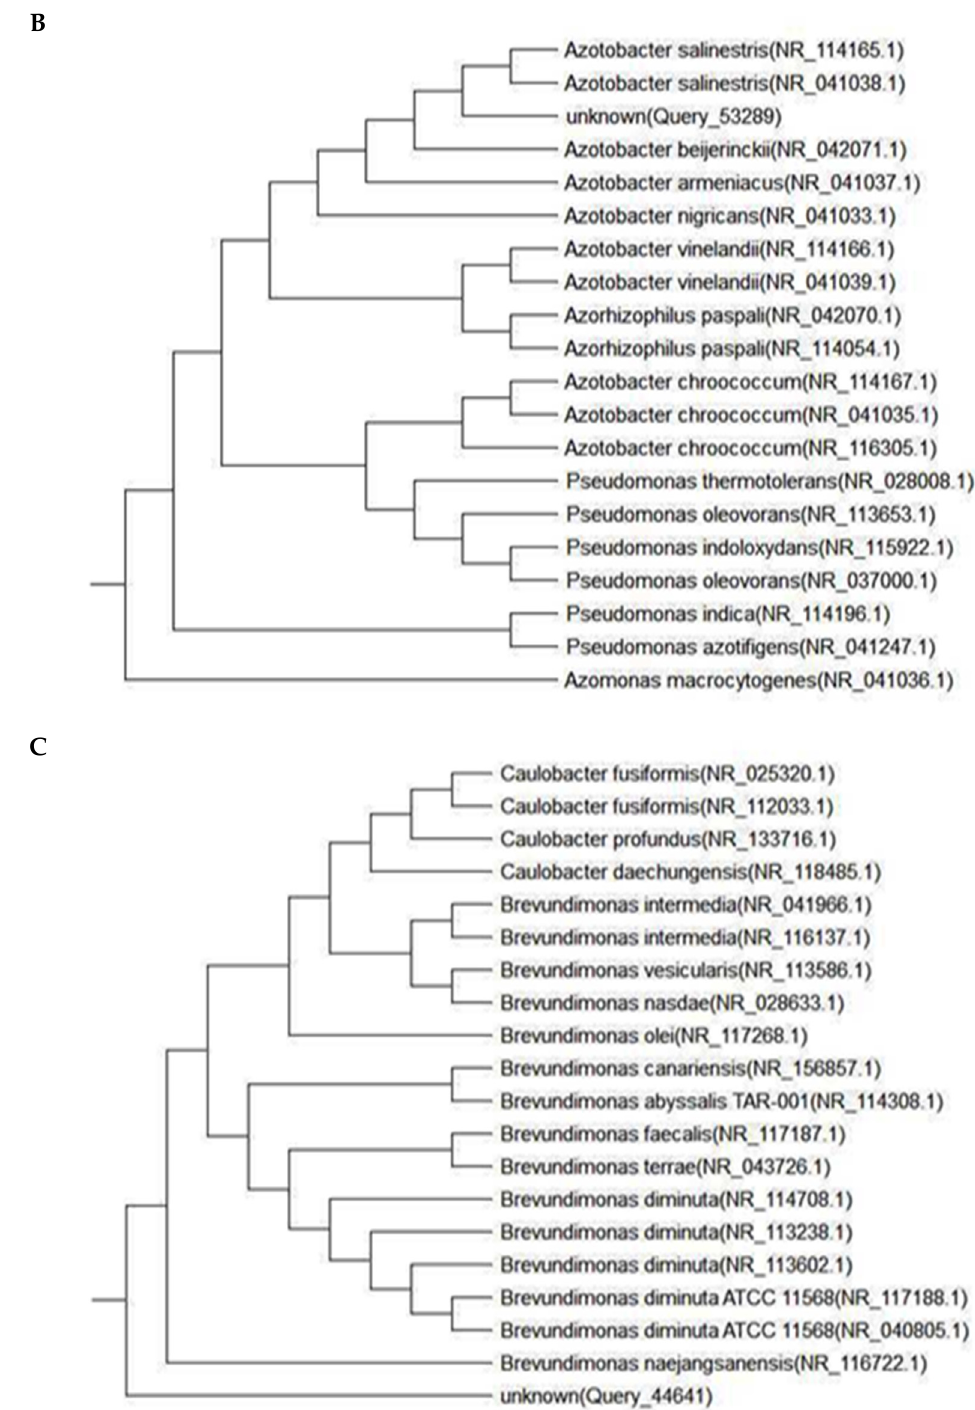
Figure 1. Genotype tree of Bacillus paramycoides MCCC 1A04098 ( A ), Azotobacter salinestris NBRC 102611 ( B ) and Brevundimonas naejangsanensis BIO-TAS2-2 ( C ).